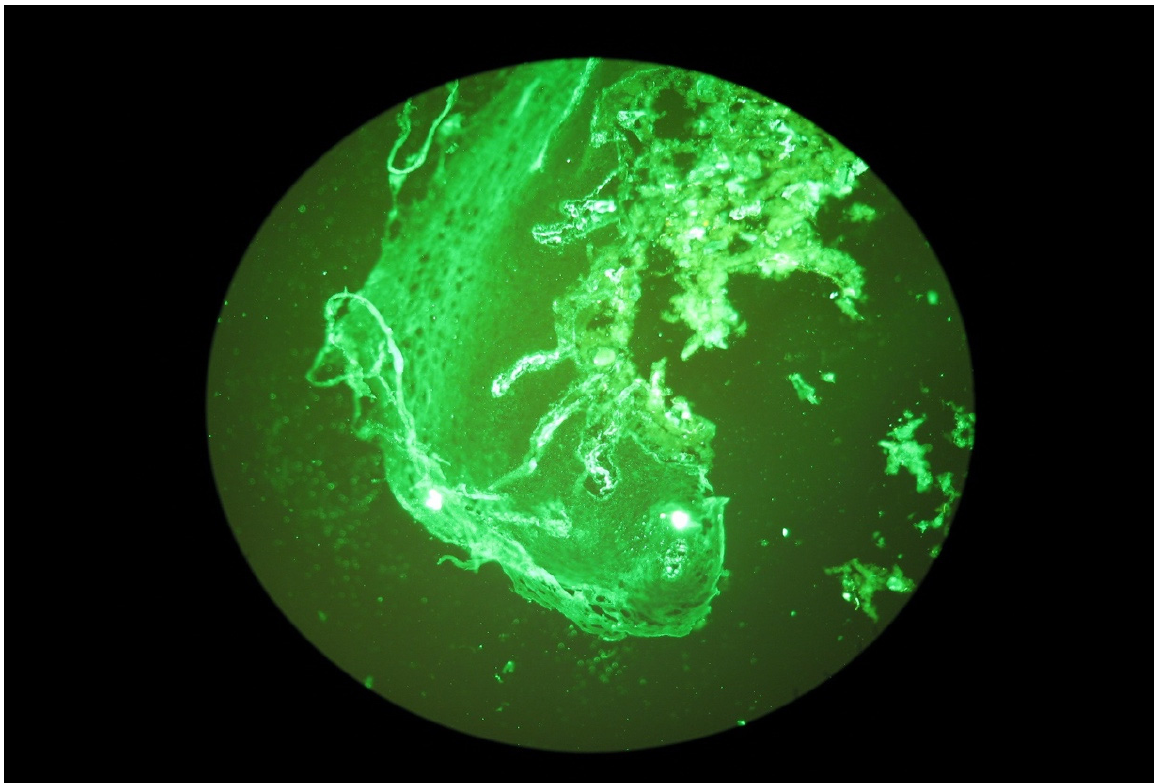
Figure 4. Granular IgA deposits dispersed in stromal cells.